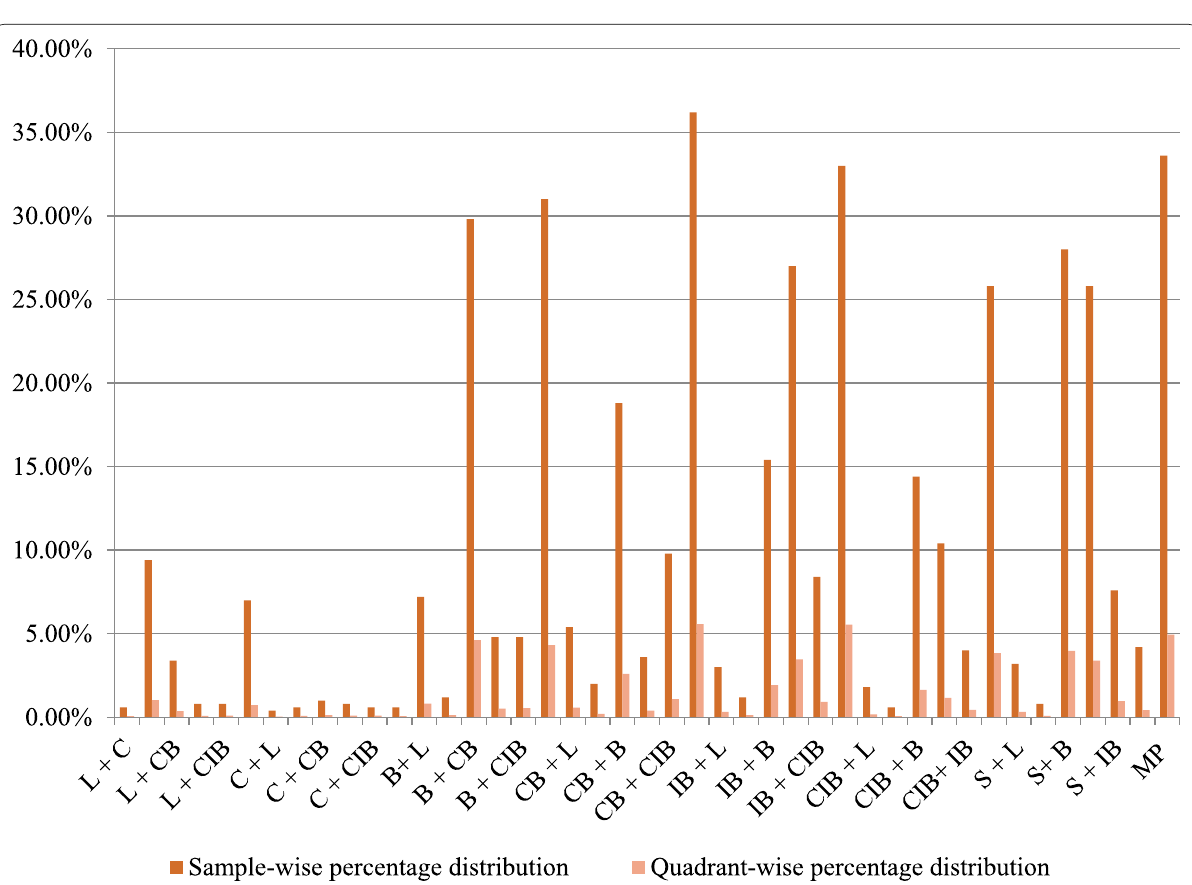
Fig. 3 Graph showing sample-wise and quadrant-wise percentage distribution (the data is given in Table 5) of Combination